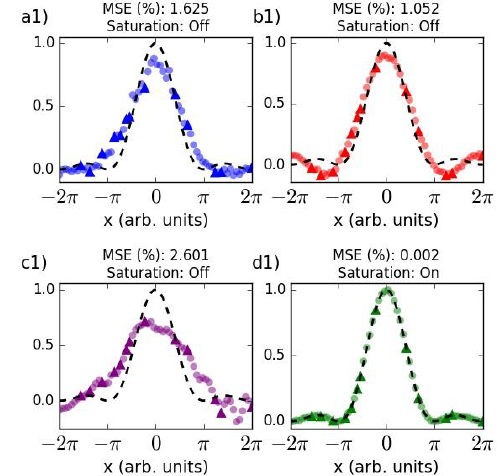
Fig. 3. Regression task performance under phase modulation of the wavefront. The target function is represented by the dashed line. a1) and b1) rely on a simple linear encoding mechanism, while c1) bears a non- linear encoding (see table 1). All with linear detection on the camera. d1) employs the same encoding as b1), but with non-linear detection (i.e. camera saturation). Semi- transparent circles represent training data and opaque triangles test